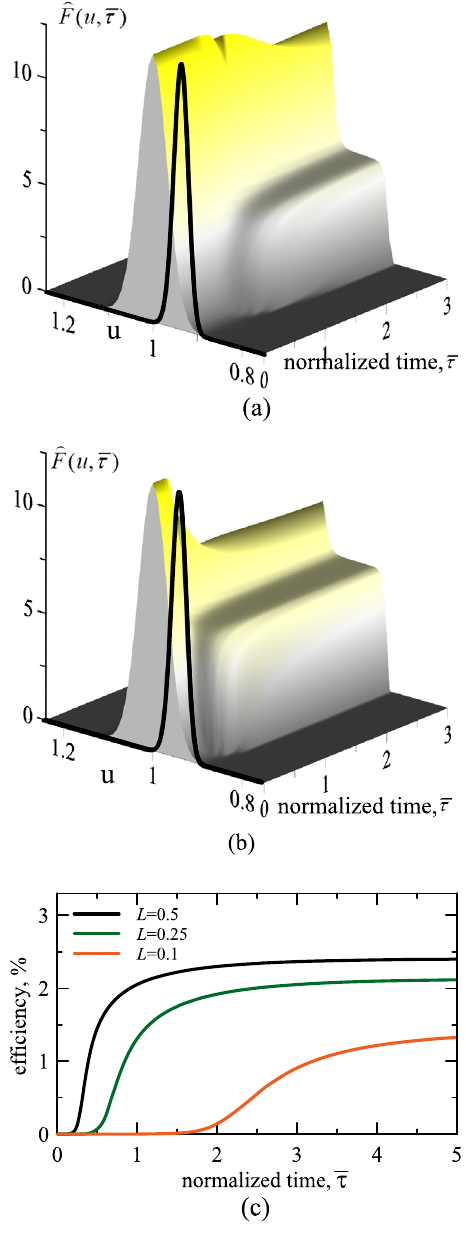
FIG. 5. Oscillator with the high-Q resonator. Temporal evolu- ⌢ ð u; ¯ τ Þ for different tion of the electron distribution function F ~ L ¼ 0 ~ L ¼ 0 resonator lengths (a) . 25 , (b) . 5 . Profile of pump spectrum is shown by the black line. (c) Corresponding depend- ences of electron efficiency on time ¯ τ : δ ¼ 0 . 035 , σ ¼ 0 . 035 , ε ¼ 0 . 05